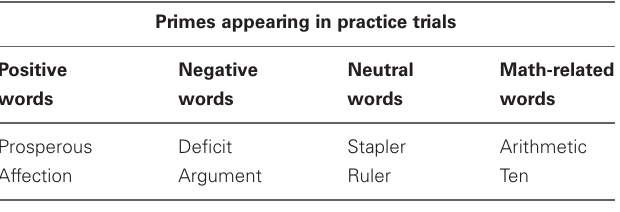
Table A3 | Targets used in the experiment. Table A4 | Primes and targets used in the practice